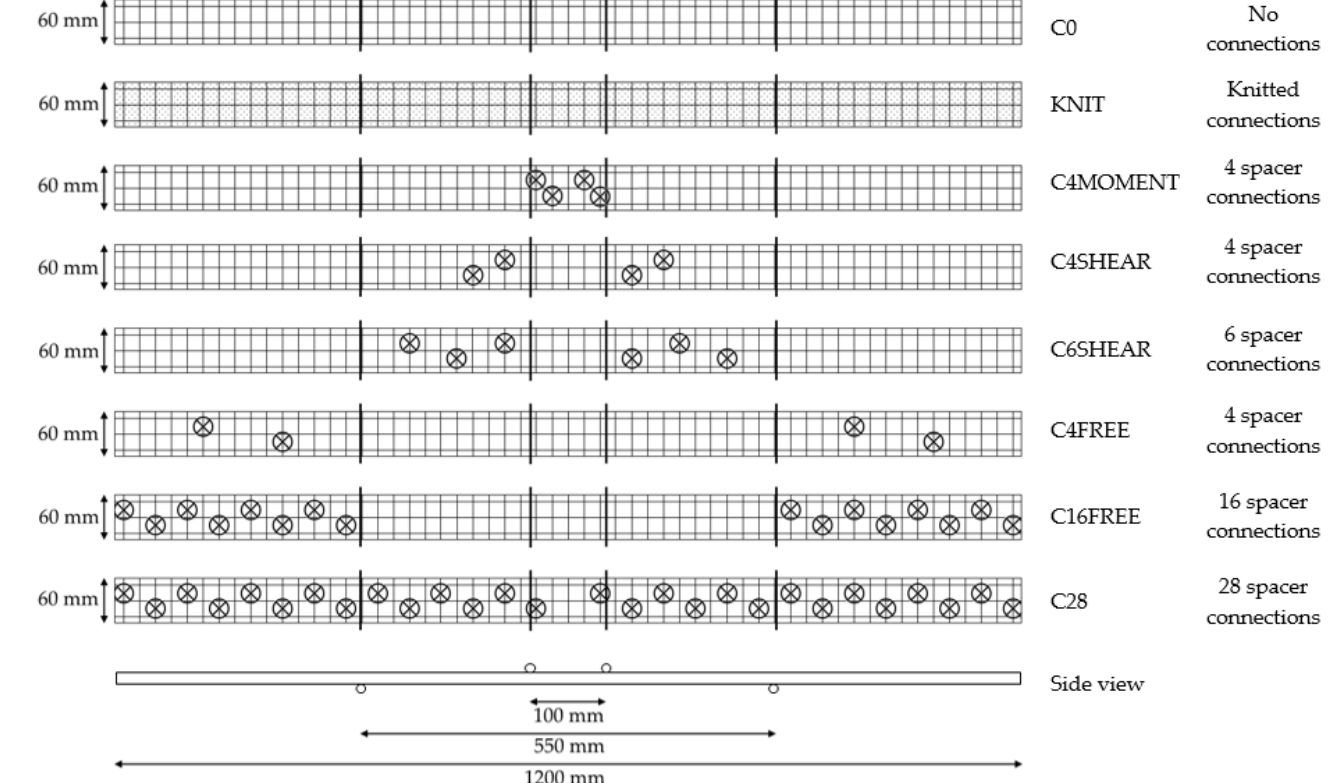
Figure 4. Configurations of the considered TRCs, indicating the location of the spacers and the loading setup.